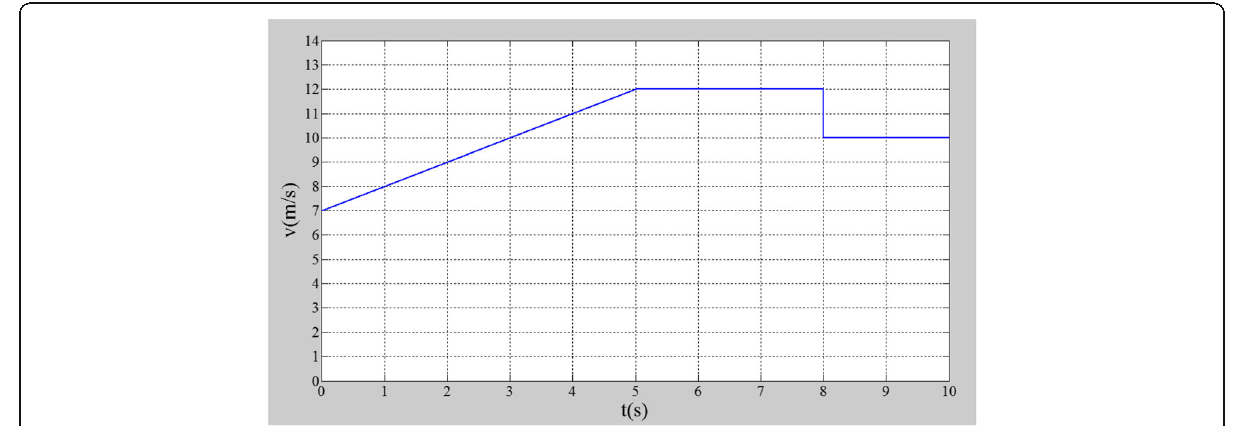
Fig. 7 Wind speed curve. In Fig. 7, X -axis is time (s) and Y -axis is wind speed